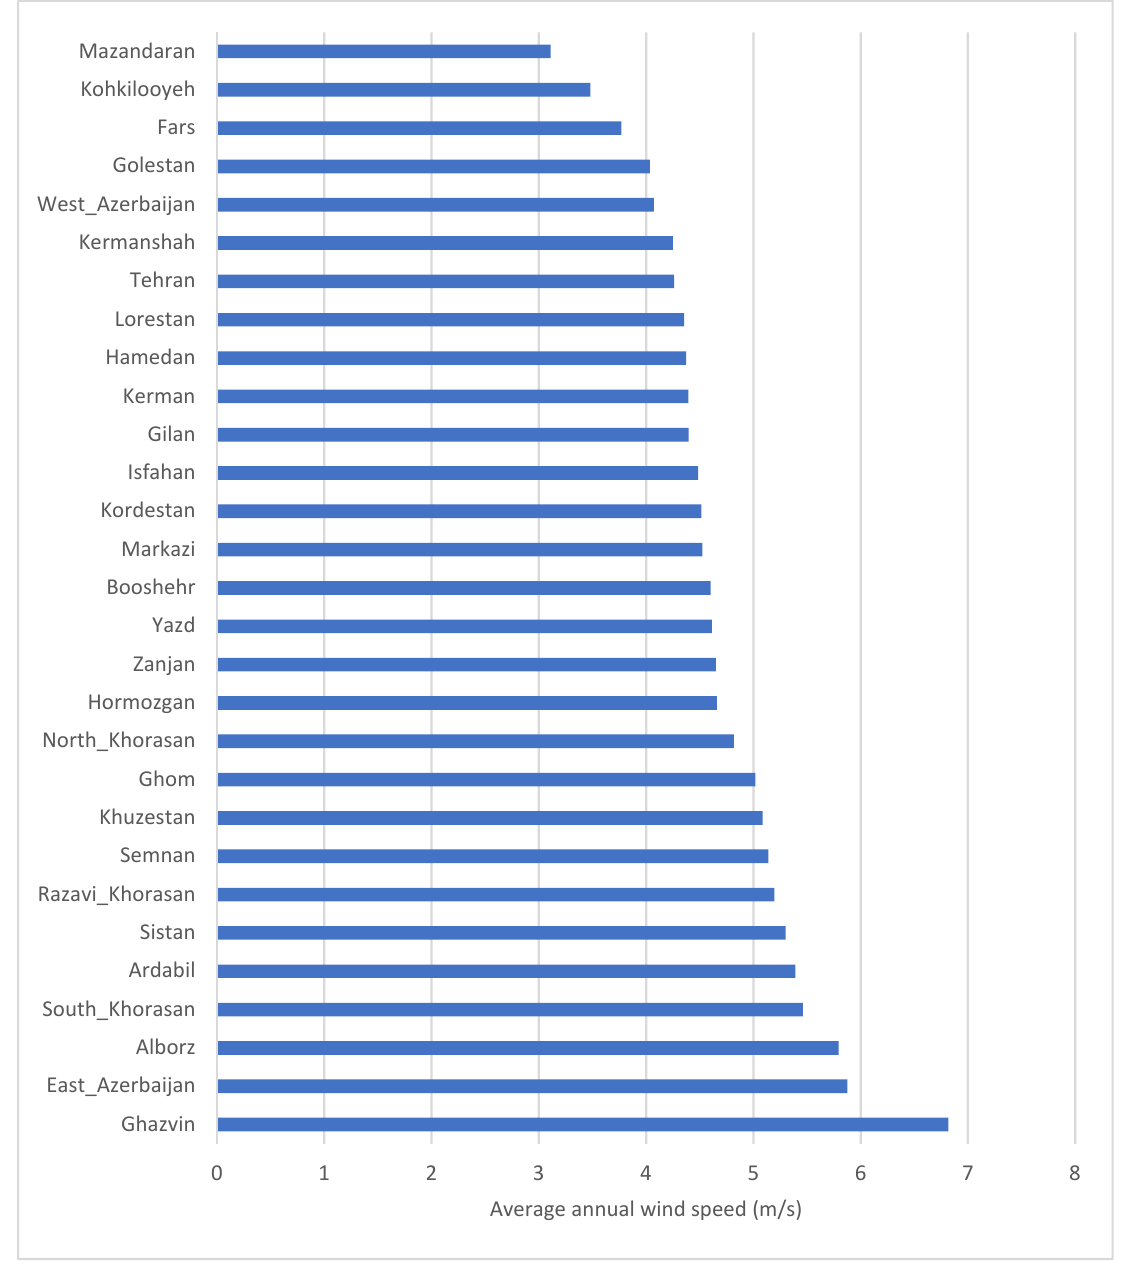
Figure 3. Average annual wind speed in Iranian provinces.